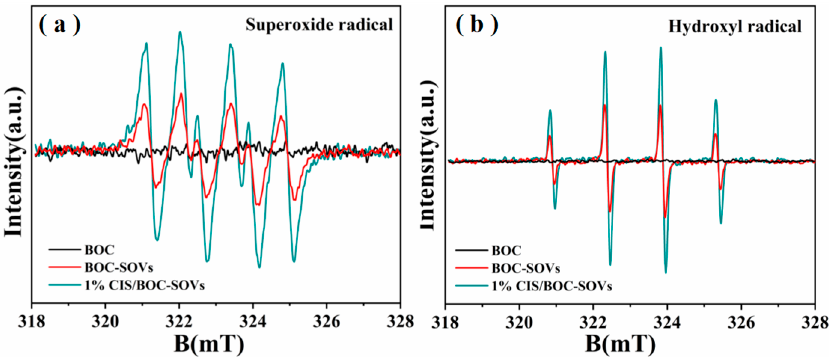
Figure 12. DMPO spin-trapping ESR spectra of BiOCl, BOC-SOVs and 1% BOC-SOVs for DMPO- · O 2 − ( a ) and DMPO- · OH ( b ) under visible light irradiation. Accordingly, a reasonable photocatalytic mechanism can be proposed as